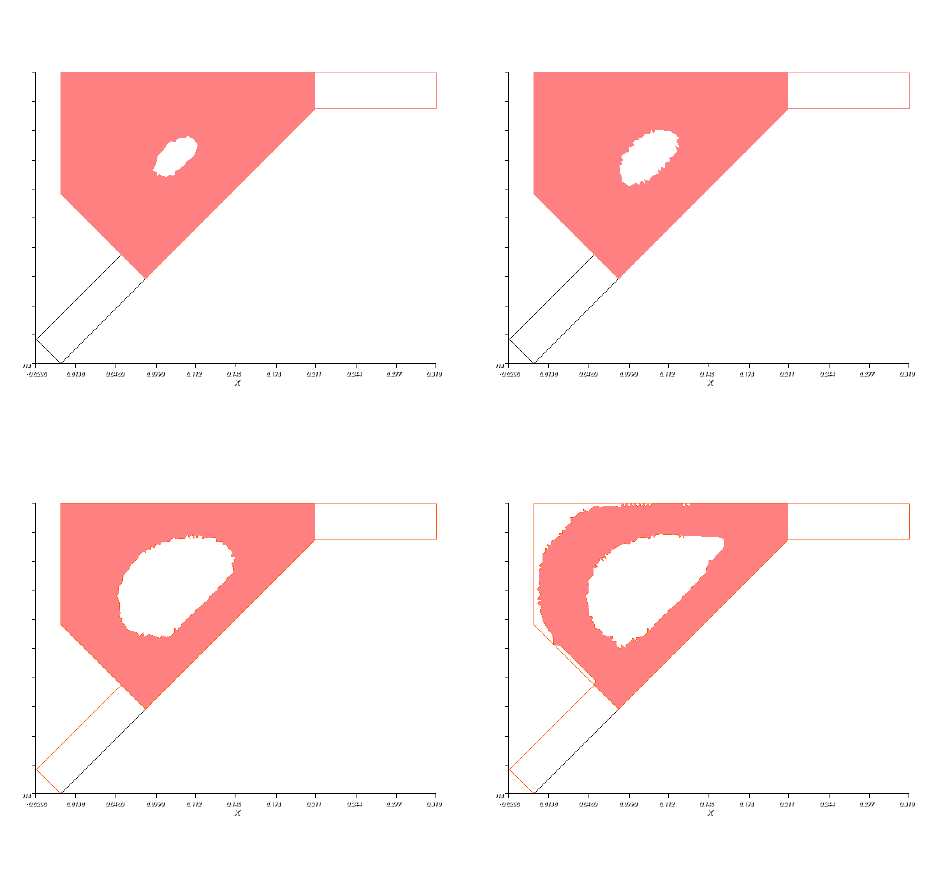
Fig. 4: Geometries obtained during the optimization process